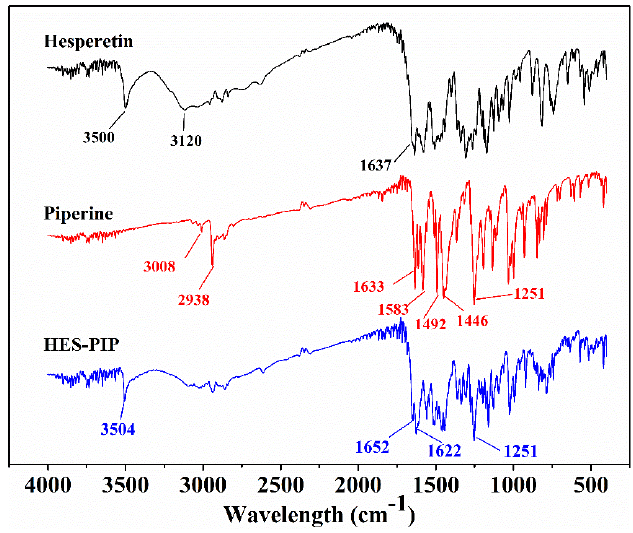
Figure 5. FTIR spectra of HES–PIP cocrystal, HES and PIP.